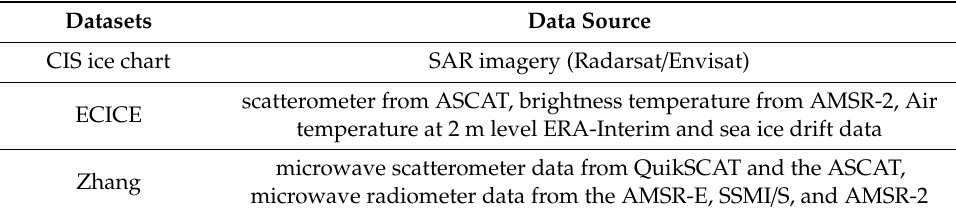
Table 2. Comparison datasets.